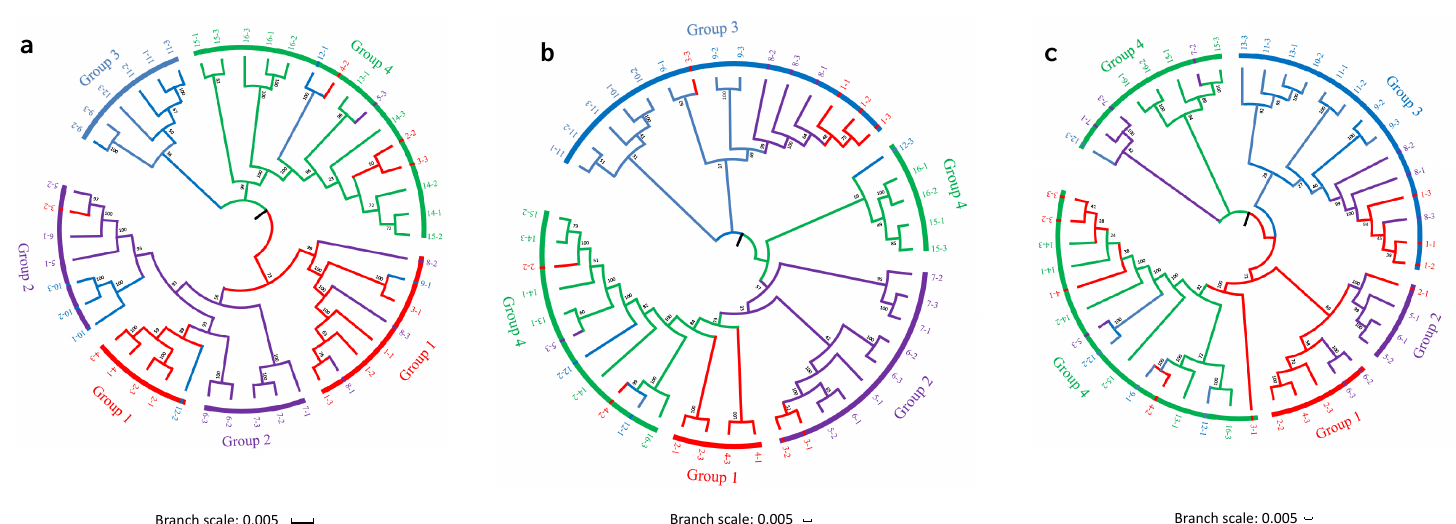
Figure 1. Maximum-likelihood phylogeny of 16 populations of C. dactylon . ( a ) phylogeny of C. dactylon at 5 ◦ C. ( b ) phylogeny of C. dactylon at 20 ◦ C. ( c ) phylogeny of C. dactylon at 35 ◦ C. Group 1 contains populations 1–4; Group 2 contains populations 5–8; Group 3 contains populations 9–12; Group 4 contains populations